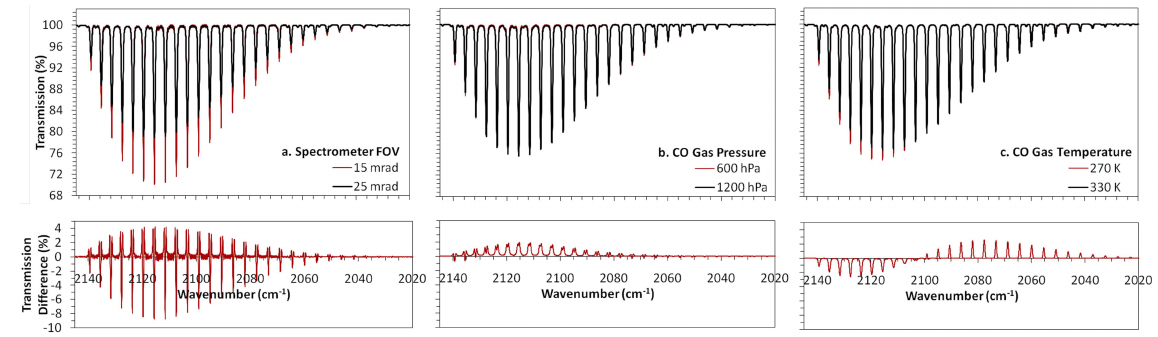
Fig. 11. Simulated transmission spectra for CO gas at a fixed molecular amount of 6.424 × 10 17 moleculescm − 2 , along with percentage difference in transmission between the CO transmission spectra simulated using (a) an assumed FOV of 15mrad and 25mrad; (b) at 600 and 1200hPa; and (c) at 270K and 330K. The figure focuses on the p -branch of the CO vibrational stretching mode absorption feature, centred at 2143cm − 1 . Increasing FOV leads to broader, but weaker absorption lines; increasing pressure leads to deeper and broader absorption lines; whilst increases in temperature lead to stronger absorption towards the edge of the band (wavenumbers < 2100cm − 1 ) and weaker absorption towards the band centre (wavenumbers > 2100cm − 1